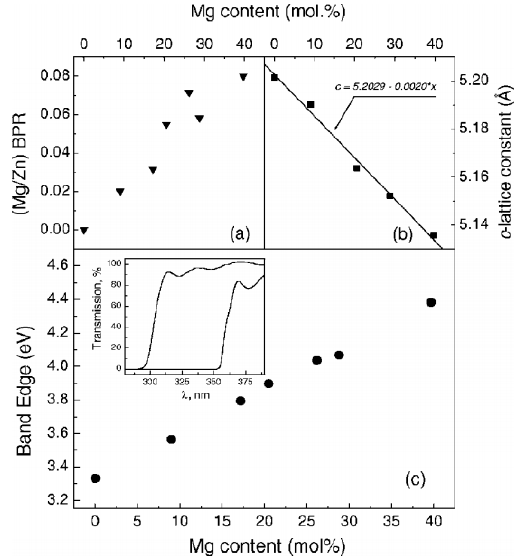
Figure 2. The variation ( a ) BPR—beam-equivalent-pressure ratio of Mg to Zn beams during MBE growth, ( b ) c-lattice constant, and ( c ) room temperature band gap versus Mg content. In 700 nm thick ZnMgO MBE-grown epilayers. Inset: optical transmission spectra for x = 0.10 (right), 0.40 (left). Reprinted from Sadofev, S., Blumstengel, S., Cui, J., Puls, J., Rogaschewski, S., Schäfer, P., Sadofyev, Yu. G., and Henneberger, F., Growth of high-quality ZnMgO epilayers and ZnO ∕ ZnMgO quantum well structures by radical-source molecular-beam epitaxy on sapphire, Appl. Phys. Lett. , 2005 , 87, 091903; DOI: 10.1063/1.2034113, with the permission of AIP Publishing.